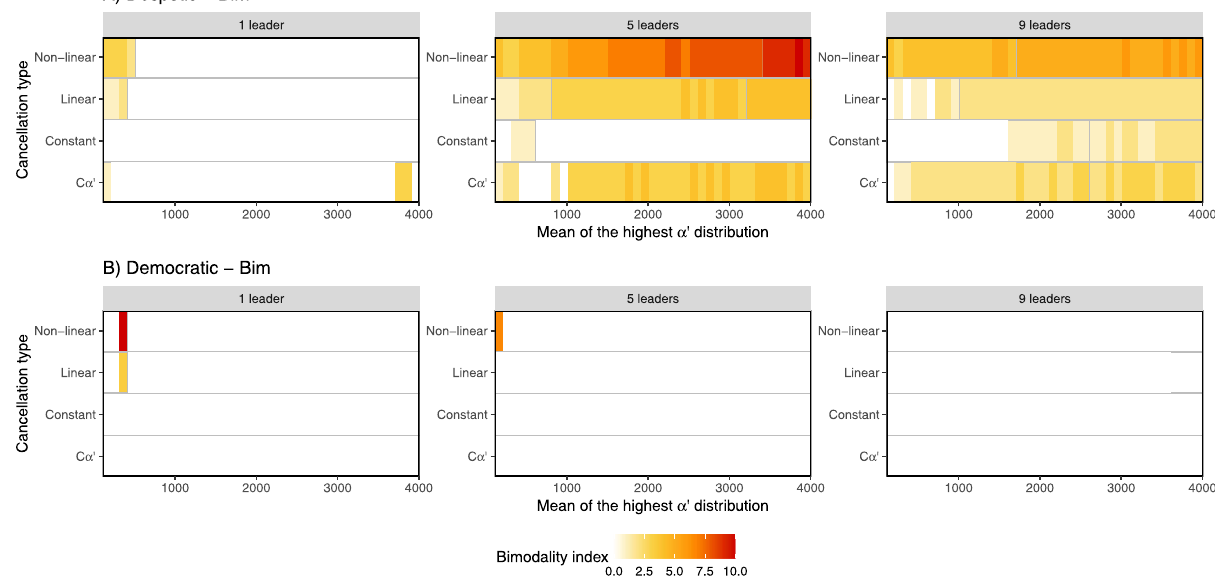
Fig. 4 Scenarios where a bimodal distribution of the number of responders was produced under the Bim condition. Scenarios where bimodality was produced under A despotic and B democratic scenarios. Y -axis indicates the cancellation type and the x -axis is the range of difference in α ’ values. For each condition, we show results for simulations with 1, 5 or 9 leaders (see Supplementary Figs. S2 and S5 for more results). The fi rst column of each graph corresponds to the control simulation without personality as α ’ = 160 for all individuals. For the following columns the mean of the low α ’ distribution was fi xed at 160, while the mean of the highest α ’ distribution is shown on the x -axis. The probability of joining per second (one timestep) is equal to 1/ α ’ . The colour scale indicates the bimodality index (see Methods for computation details); the higher the index, the higher the degree of bimodality (see also Supplementary Figs. S1 and S4 and Supplementary Movies 1 and